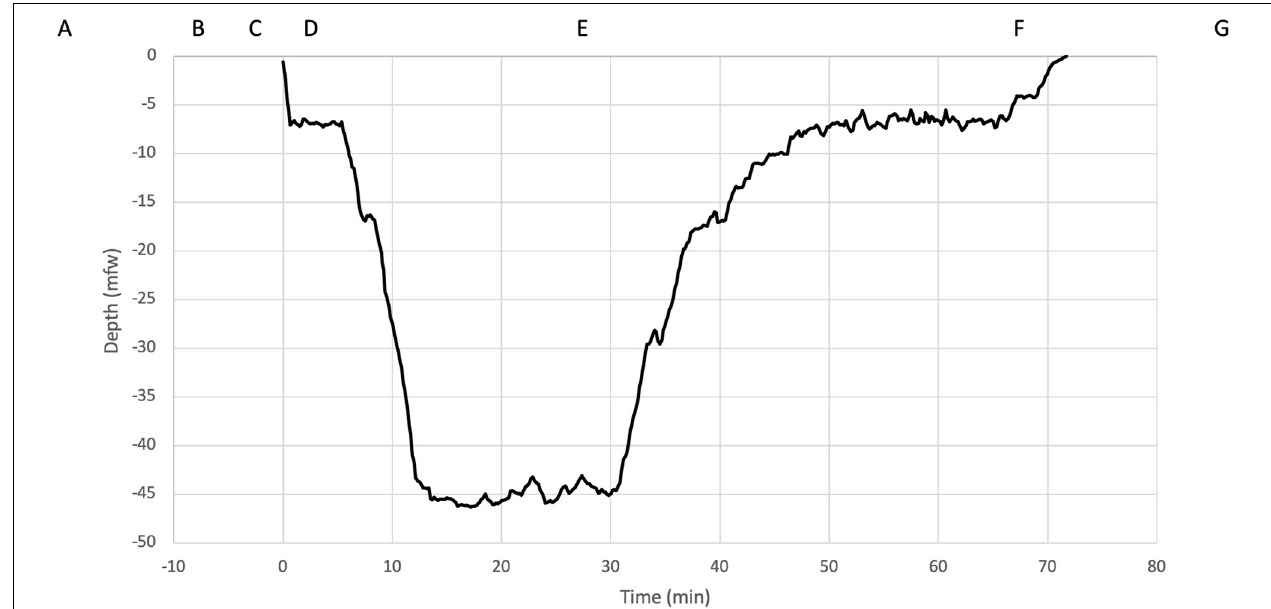
FIGURE 1 | Five-minute HRV measurements were performed at the following time points indicated in boxes: (A) rest before the dive, (B) immersion, (C) face in the water, (D) submersion, (E) bottom, just before starting ascent, (F) just before surfacing and (G) rest after the dive. The dive profile (diver number nine) was downloaded from the dive computer and is shown with corresponding depths.